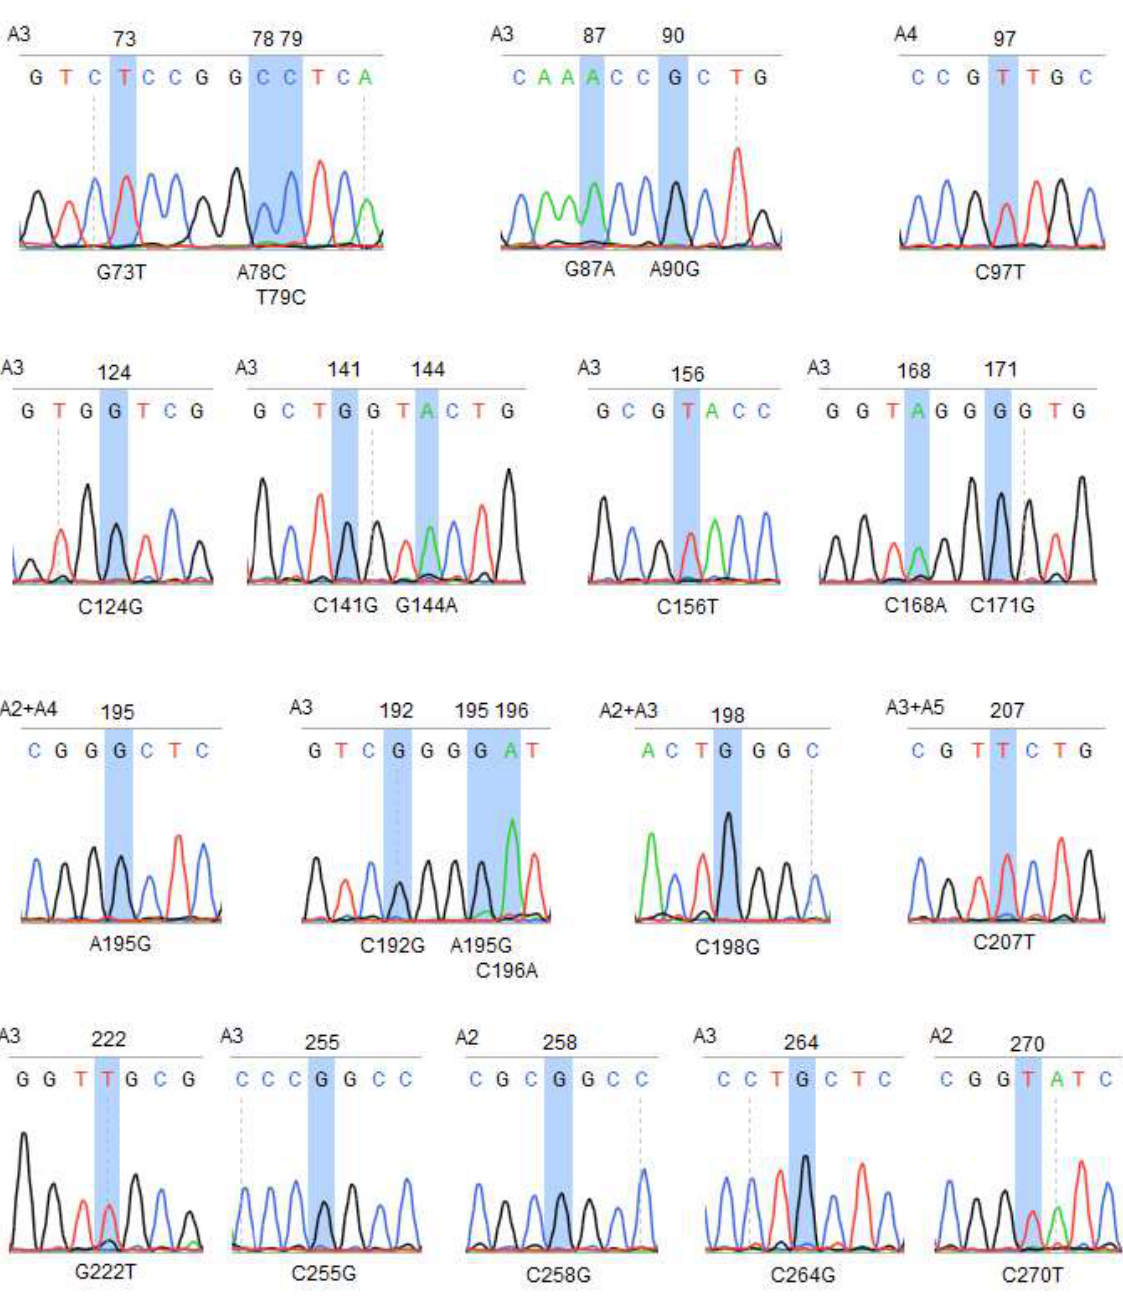
Figure (3): The Number and Location of Genetic Mutations of The QacE gene (311 bp) of The Isolates Ps-2, Ps- 3, Ps-4, and Ps-5 within the P.aeruginosa Bacterial